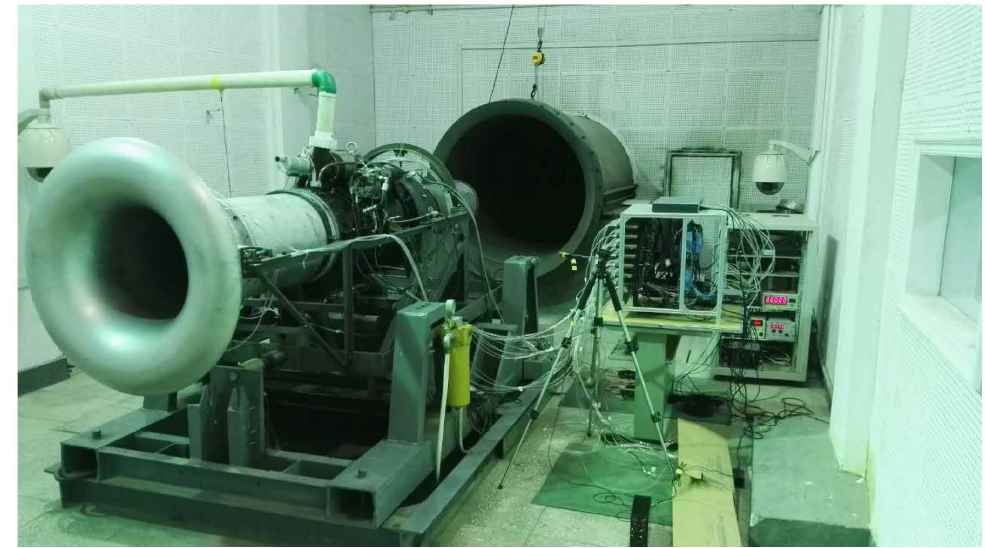
Figure 3. Test bench of the 11D turbofan aero engine.